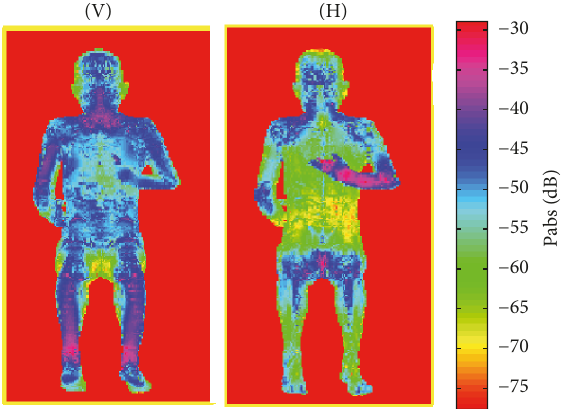
Figure 14: Distribution of the absorbed power inside the phantom after an exposure to a vertical/horizontal plane waves of 1V/m.